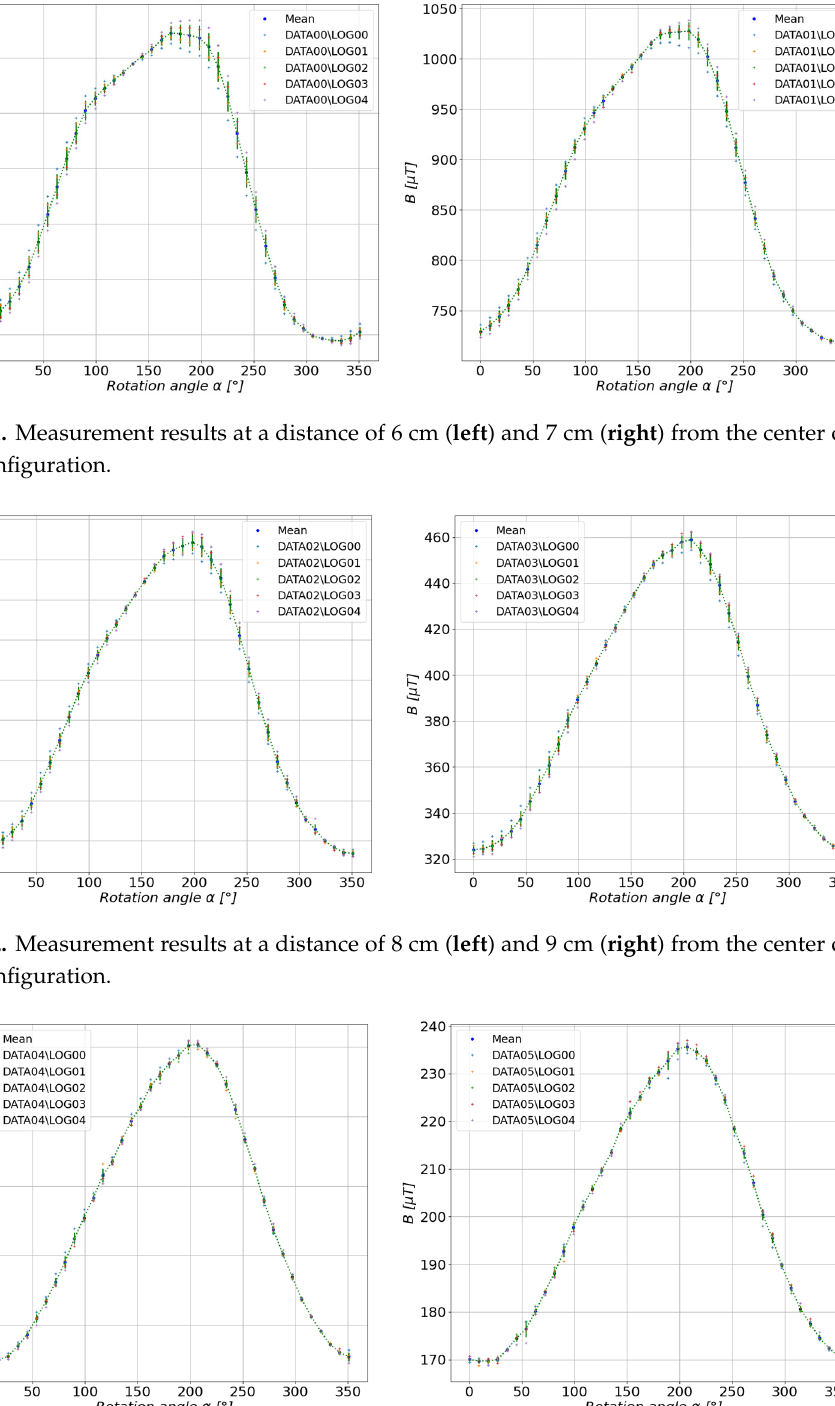
Figure 13. Measurement results at a distance of 10 cm ( left ) and 11 cm ( right ) from the center of the tested configuration.